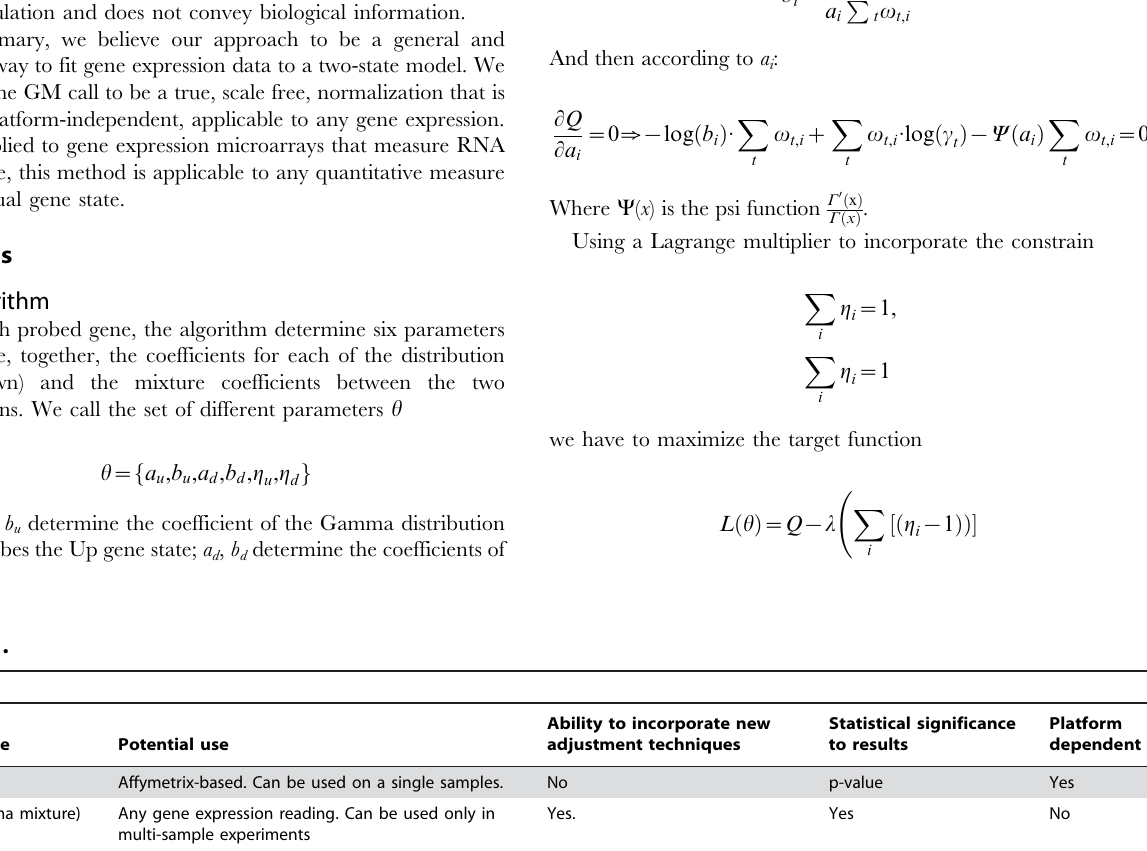
Ability to incorporate new adjustment techniques